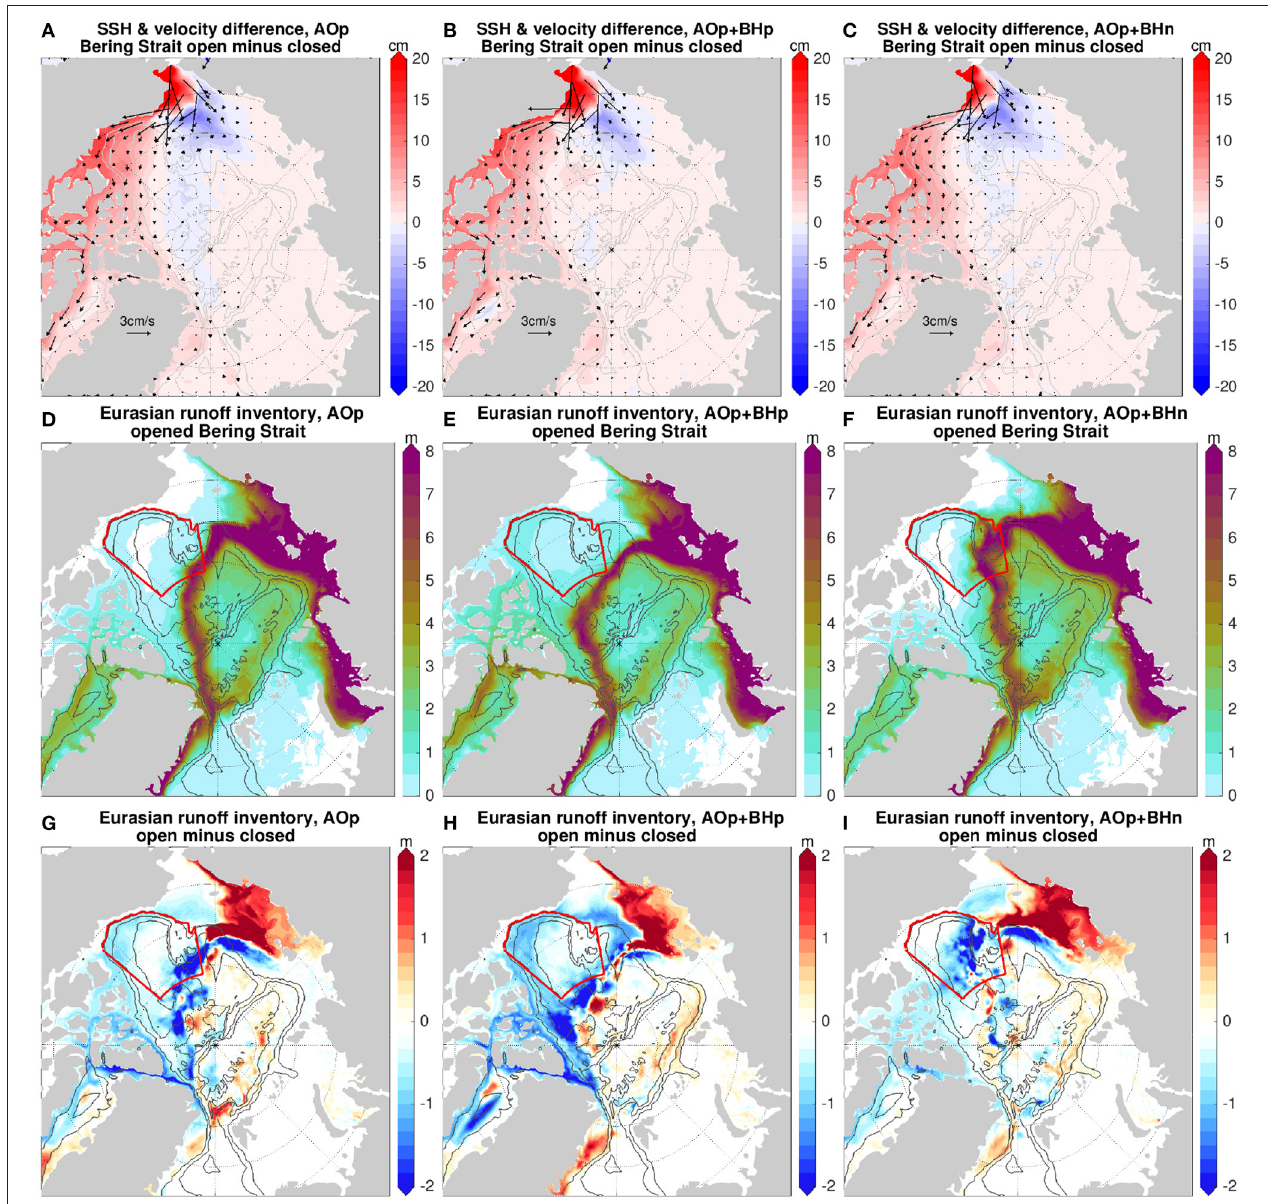
FIGURE 14 | (A–C) Difference of sea surface height (SSH) and upper 150 m mean velocity between the simulation with open Bering Strait and the one with closed Bering Strait averaged over the 10 model years: the case with (A) positive Arctic Oscillation (AO), (B) both positive AO forcing and positive Beaufort High (BH) forcing, and (C) both positive AO forcing and negative BH forcing. (D–F) The inventory of Eurasian runoff (in m) in the last model year in simulations with the Bering Strait open: (D) with positive AO, (E) with both positive AO forcing and positive BH forcing, and (F) with both positive AO forcing and negative BH forcing. (G–I) The same as (D–F) , but for the difference between the cases with Bering Strait open and the cases with the Bering Strait closed (former minus latter). The 500, 2,000, and 3,500 m isobaths are shown with gray contour lines.